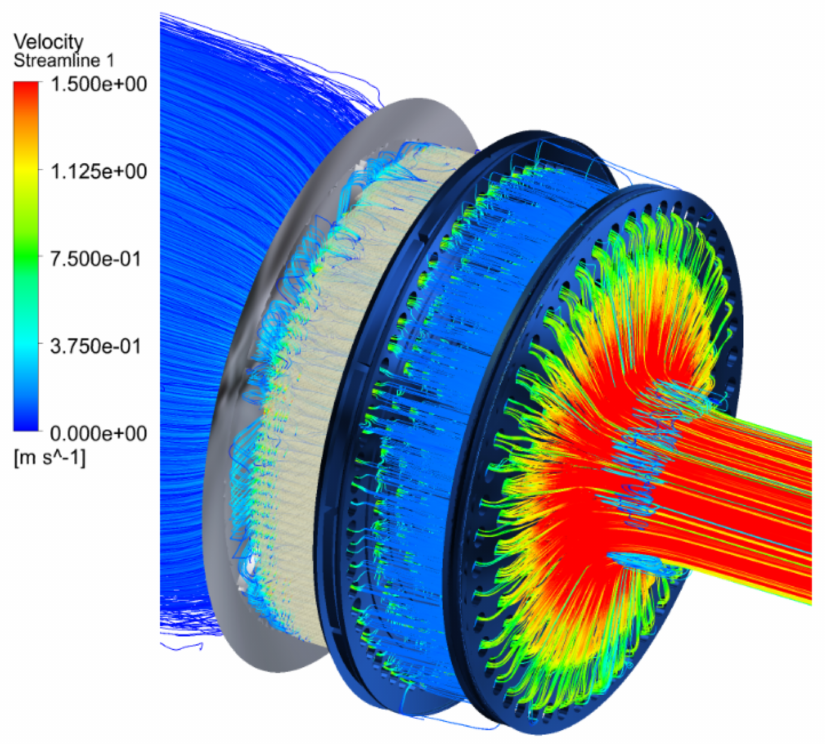
Figure 12. 3D streamlines inside canister filter components. Flow rate 70 L/s. Pleat height is 13.5 mm and spacing is 2